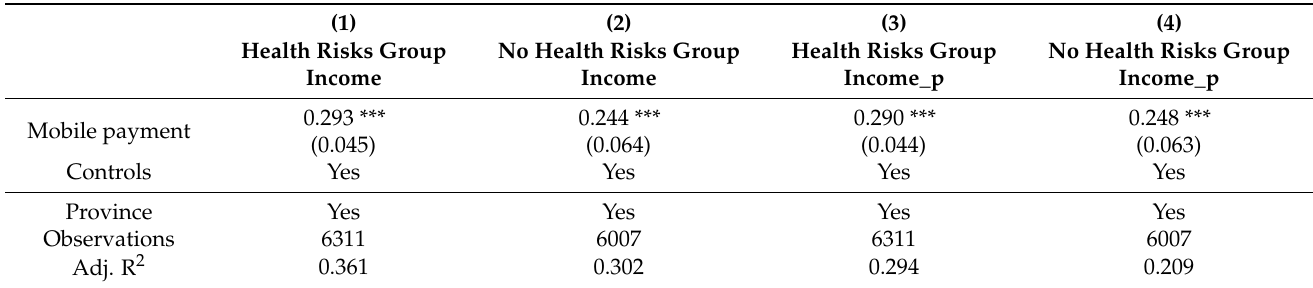
Table 8. Moderating effect of mobile payment: the OLS